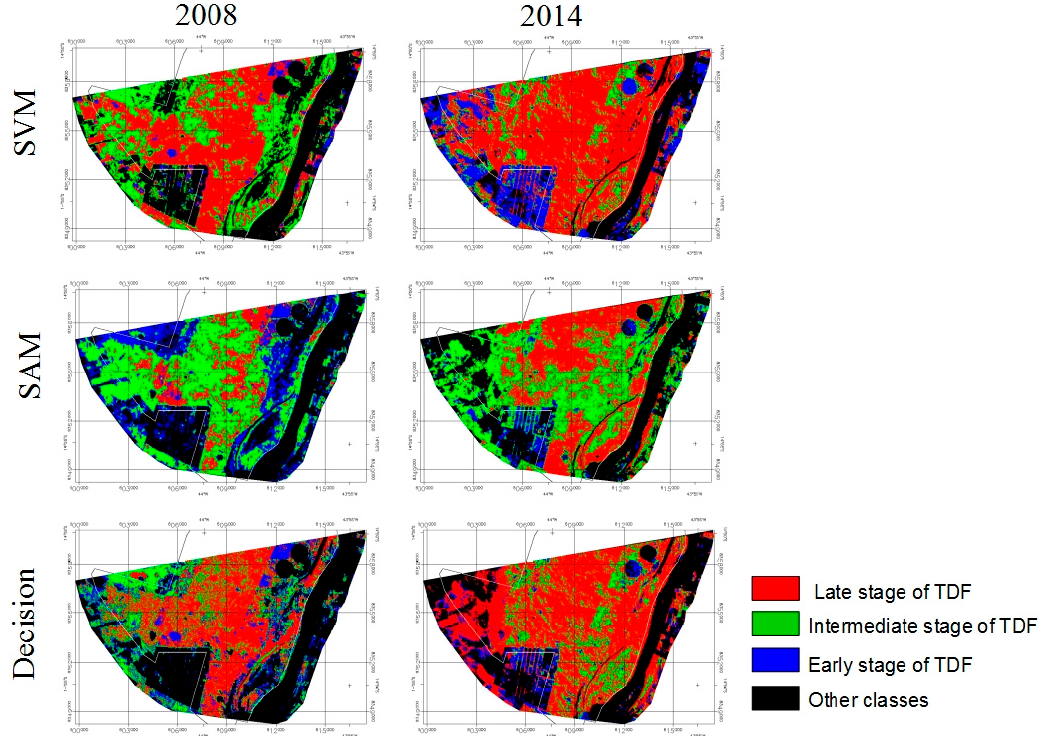
Figure 3. Class distribution of the successional stages of the TDF in PEMS (Brazil) for years 2008 and 2014 according to different classifiers.